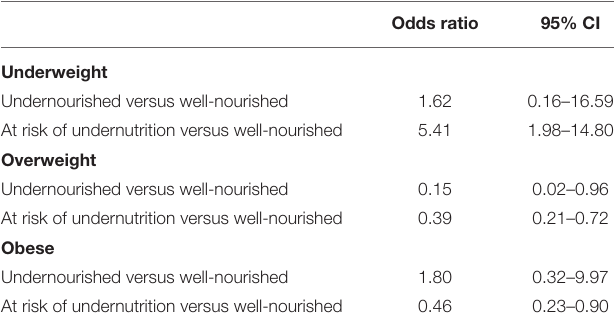
TABLE 3 | Results of the multivariate logistic regression analysis (dependent variable: weight status): odds ratio estimates for the independent variable “nutritional status” (reference: normal